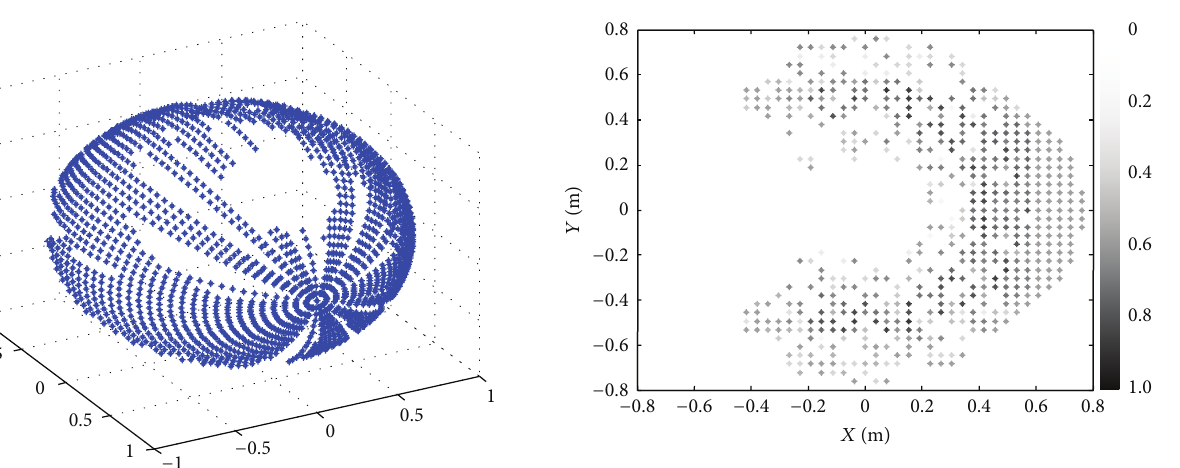
Figure 12: Omnidirectional Coefficient of plane 𝑍 = 0.21 m.